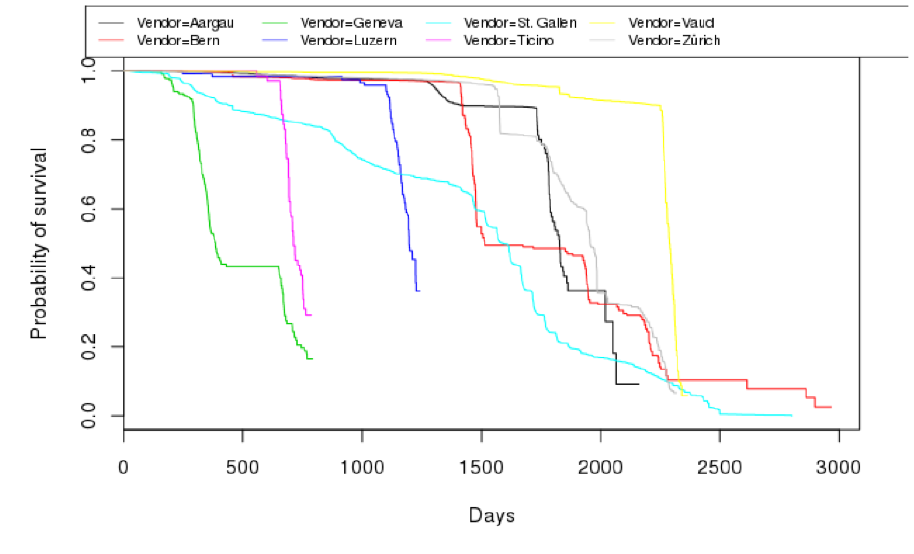
Figure 2. Kaplan-Meier survival curve: days in service by vendor